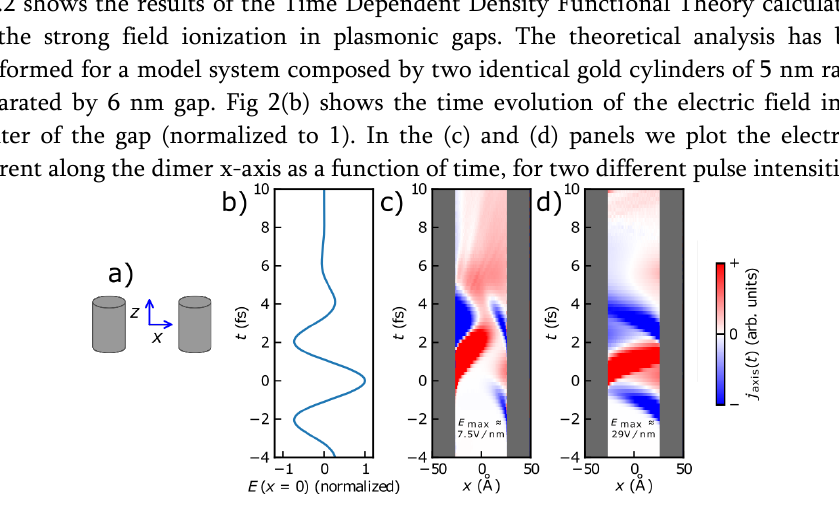
Fig. 1. (a) Sketch of the model structure employed for the calculations. (b)Electric field profile of the single cycle optical transient. (c,d) Colormap depicting the carrier density within the gap as a function of the time delay (vertical axis) for an optical field of 7.5 V/nm and 29 V/nm,